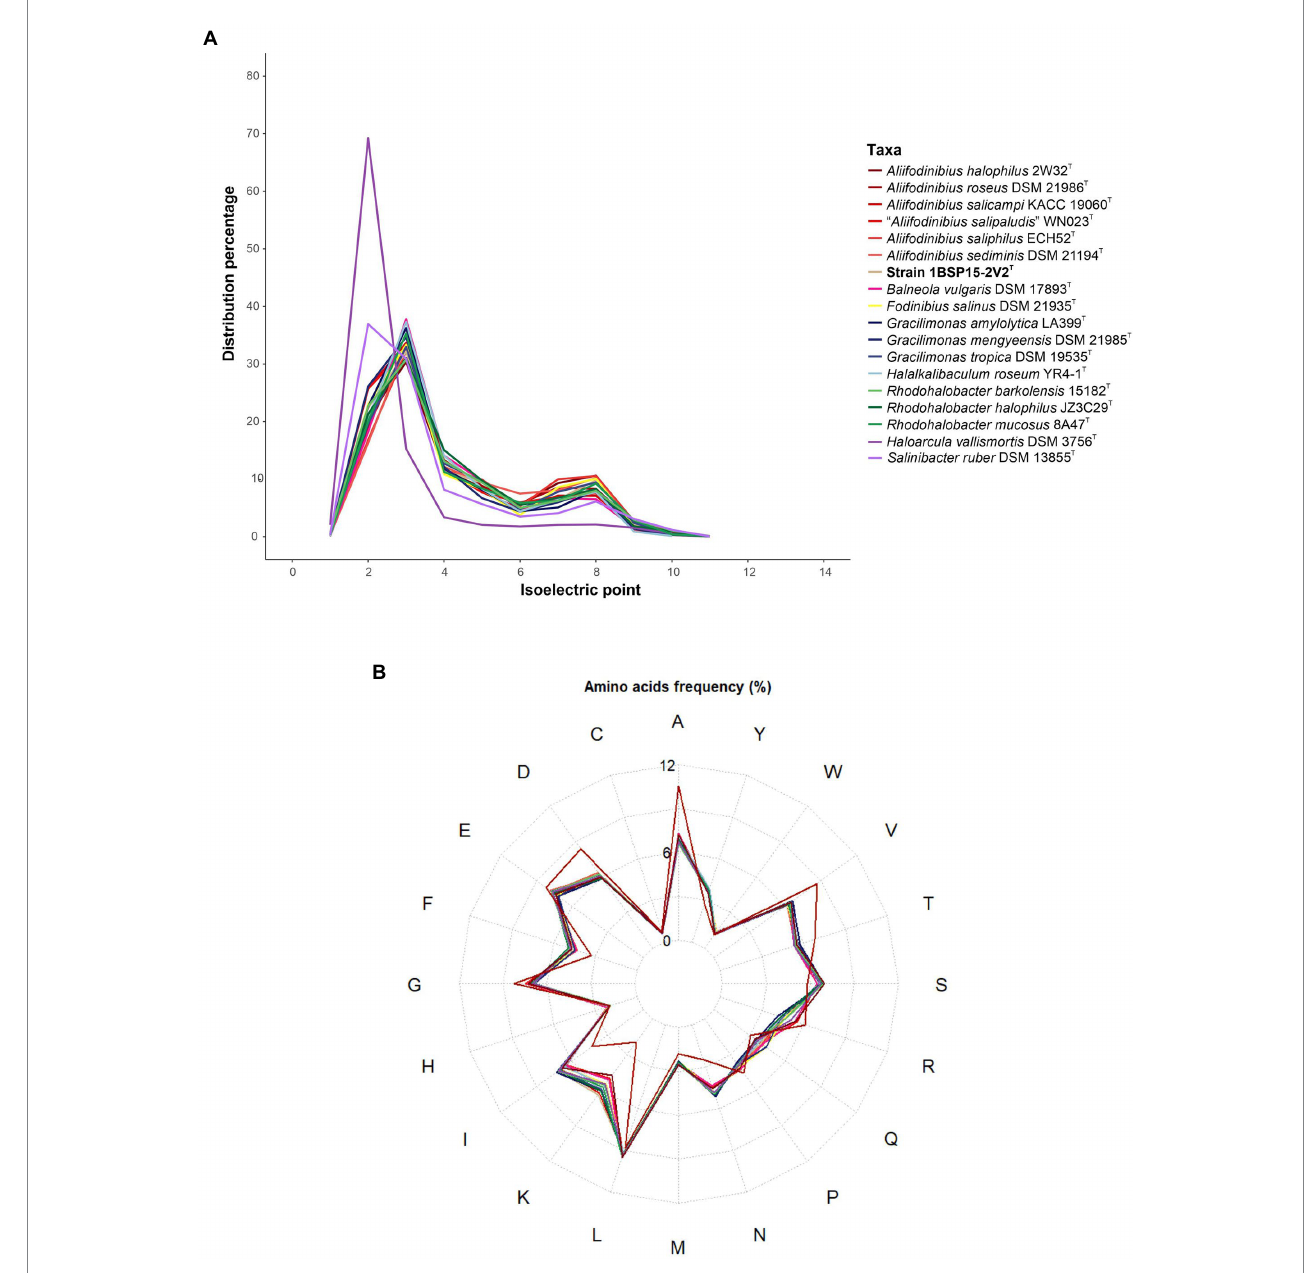
FIGURE 9 Isoelectric profile (A) and amino acid frequency (B) of the type strains of each species of the family Balneolaceae . The haloarchaeon Haloarcula vallismortis DSM 3756 T (GCF_900106715.1) and the bacterium Salinibacter ruber DSM 13855 T (GCF_000013045.1) have been included to compare our results with those of extreme halophiles with salt-in osmoregulatory mechanism. The genomes under study possessed a less acidic proteome, suggesting a salt-out strategy, though further in vivo analyses are necessary to confirm this